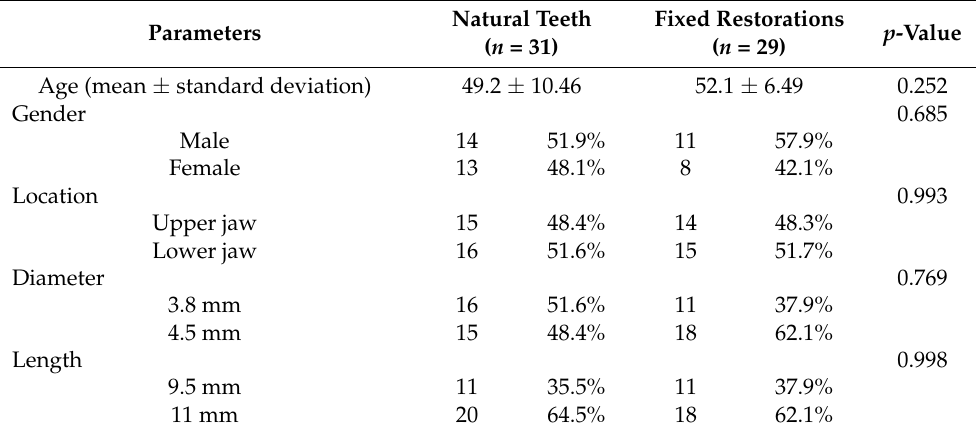
Table 1. Patient and implant characteristics at baseline.